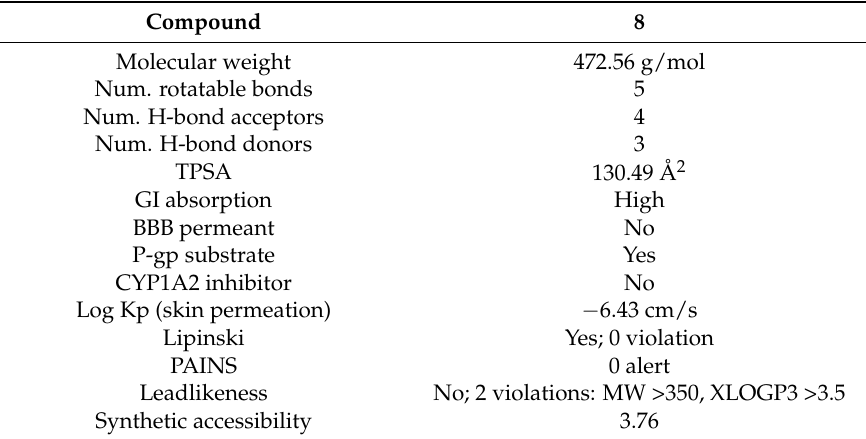
Table 2. Bioactivity and ADME